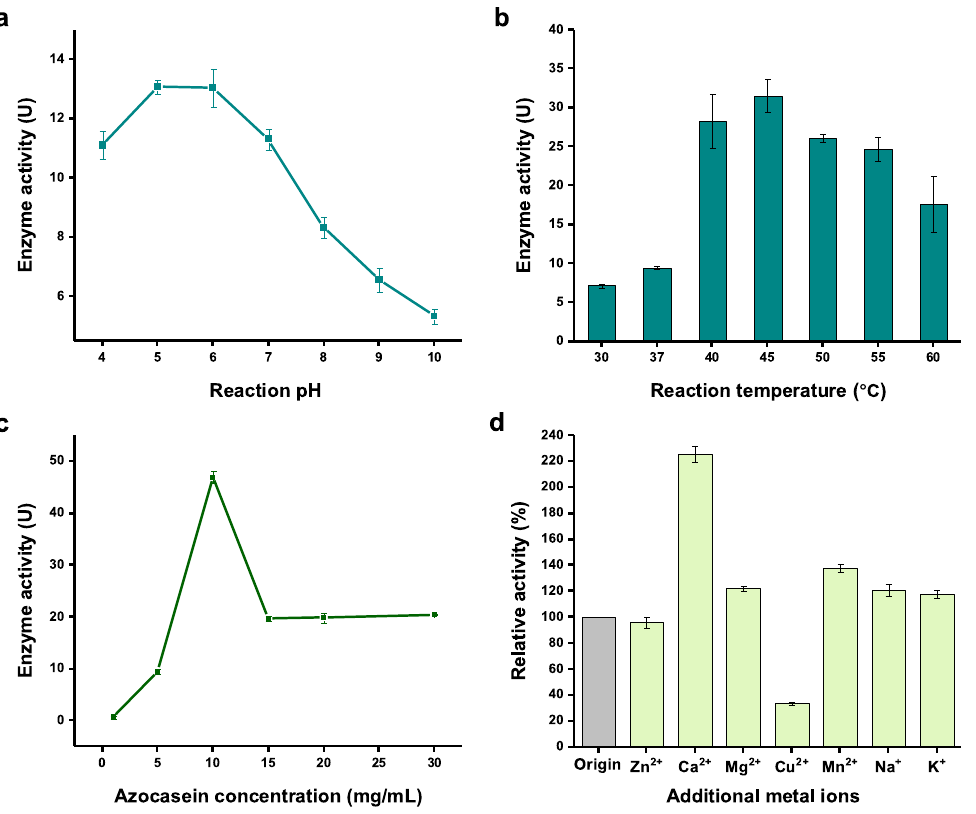
Figure 4. Optimization of physicochemical factors for the assay of serratiopeptidase activity. Effects of ( a ) reaction pH, ( b ) reaction temperature, ( c ) azocasein concentration, and ( d ) metal ions on the serratiopeptidase activity. Note that each value was calculated by subtracting the background activity. Values show means with error bars representing standard deviations (s.d.) of at least three independent experiments.